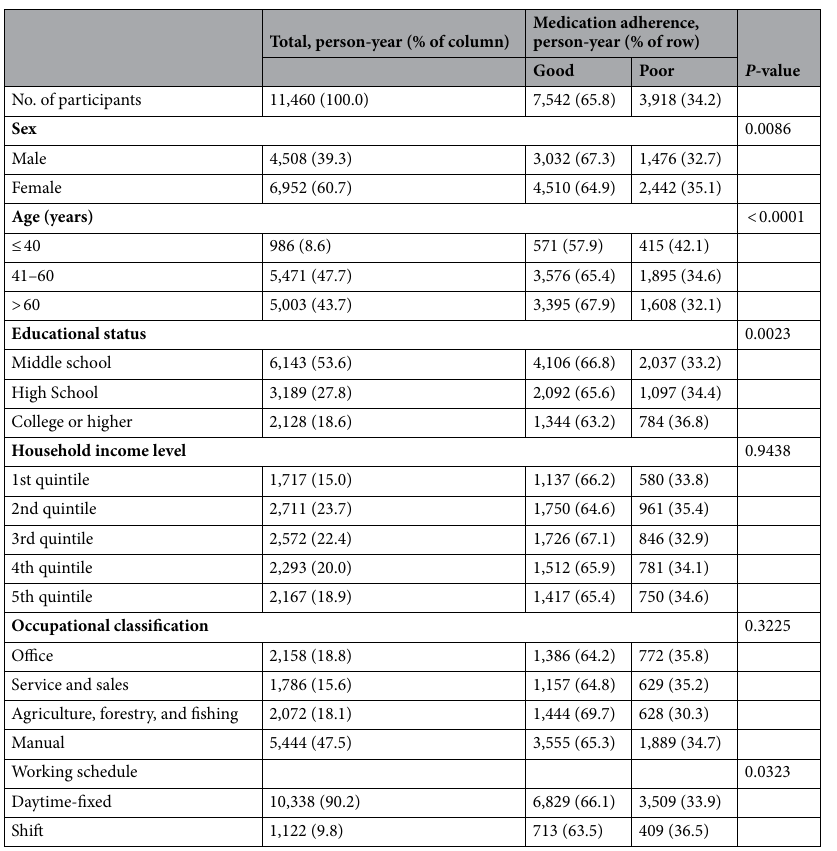
Table 1. General characteristics of the study participants with chronic diseases according to medication adherence.